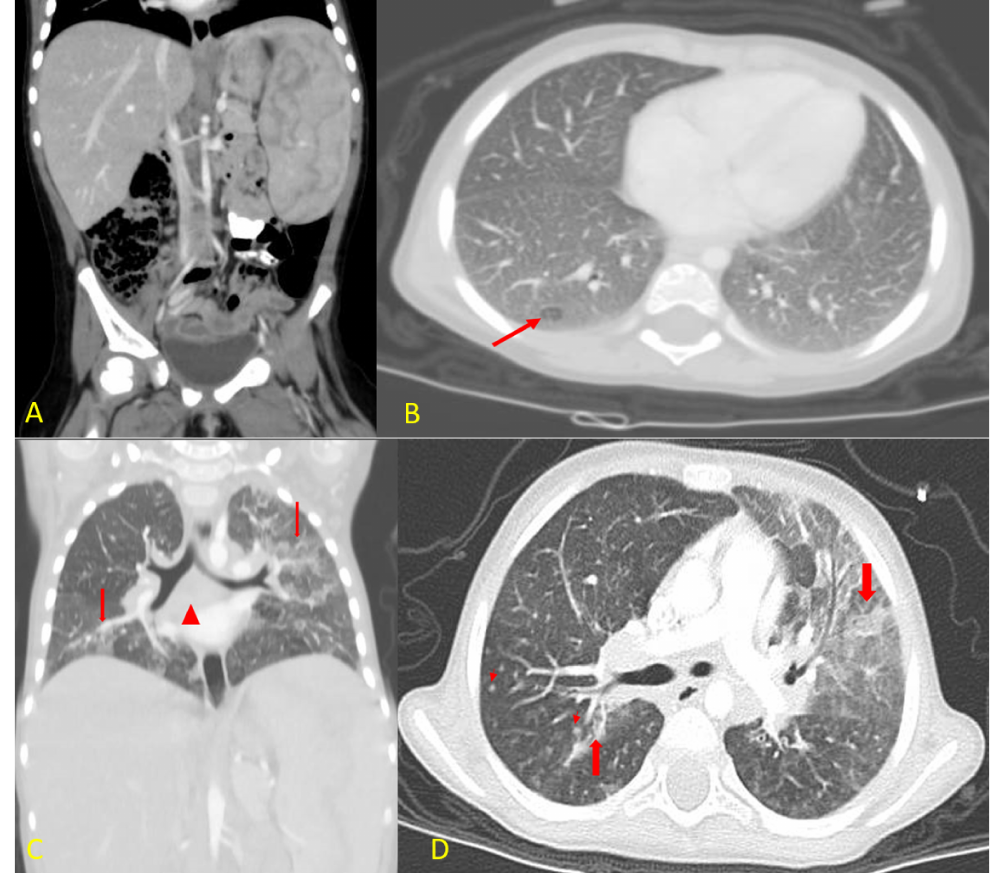
Figure 5. Patient’s CT scans in both coronal ( A , C ) and axial ( B , D ) views. ( A ) Contrasted CT scan of the abdomen and pelvis showing hepatosplenomegaly. ( B ) Axial lung window settings for lung bases demonstrating diffuse ground-glass opacity of both lung fields with diffuse smooth interstitial thickening and mosaic pattern of lung attenuation (arrow). ( C ) Coronal CT reconstruction demon- strating again the areas of consolidation, ground-glass opacity, and smooth interstitial thickening in both lung fields (thick arrows). The mediastinal lymphadenopathy, especially in the subcarinal region (arrowhead). ( D ) Axial CT scan of the chest with IV contrast lung window settings demonstrating multiple areas of consolidations (thick arrows) with surrounding ground-glass opacity, which were more prominent in the left upper lung lobe. There is also diffuse smooth interstitial thickening, and multiple small intraparenchymal lung nodules can be seen (short